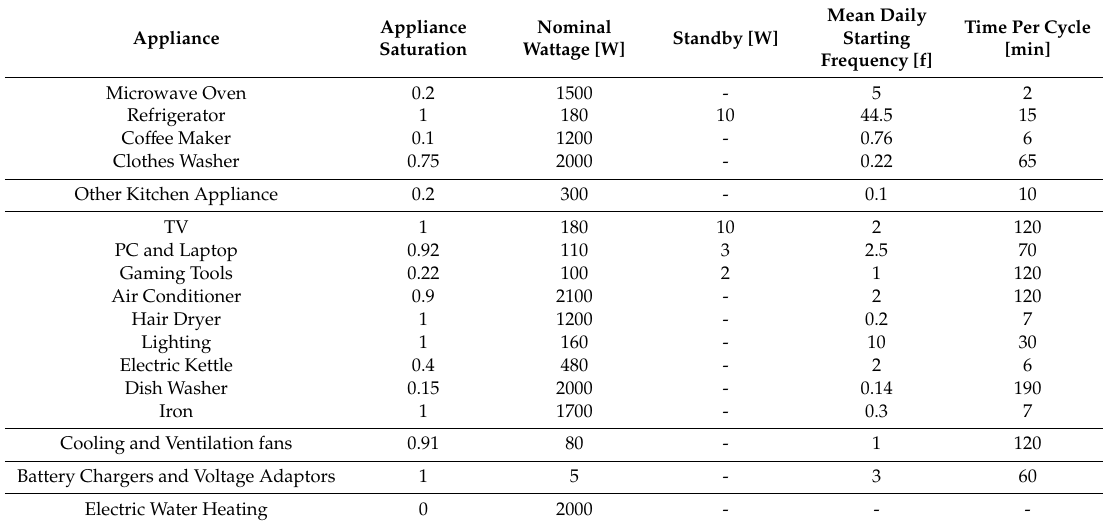
Table 2. Power consumption characteristics of household electrical